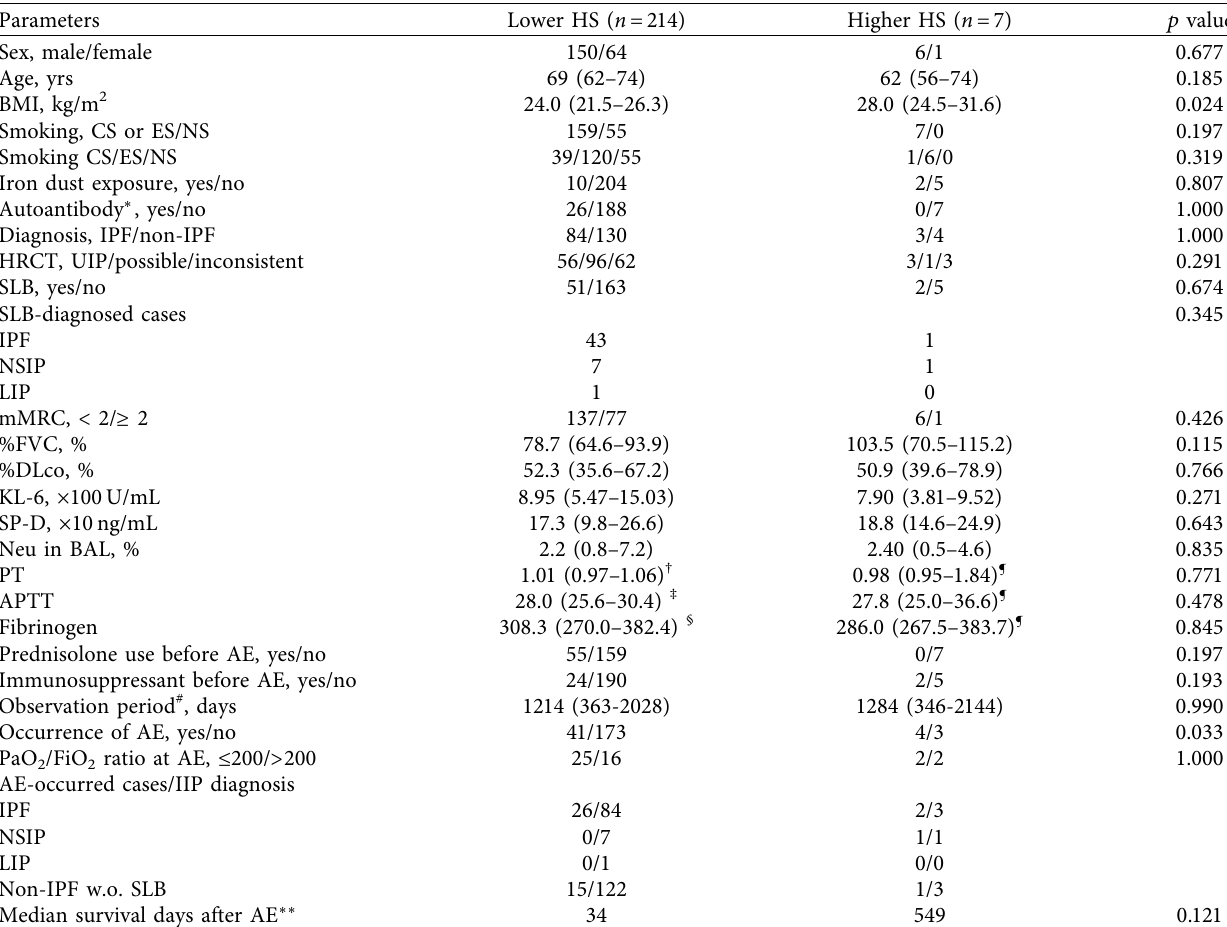
Table 1: Patient